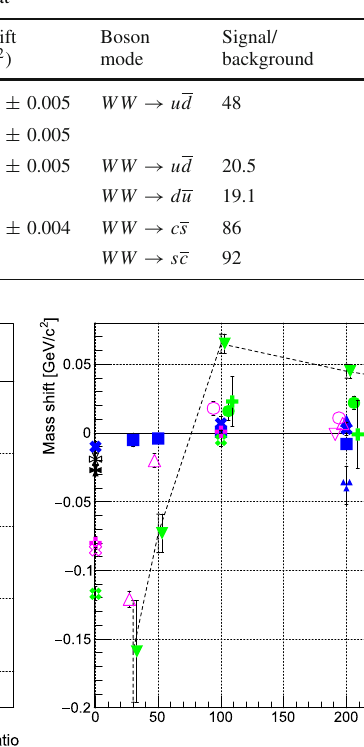
the hadronic resonance peak without experimental resolution and using only the initial and final states quoted, with negligible statistical error